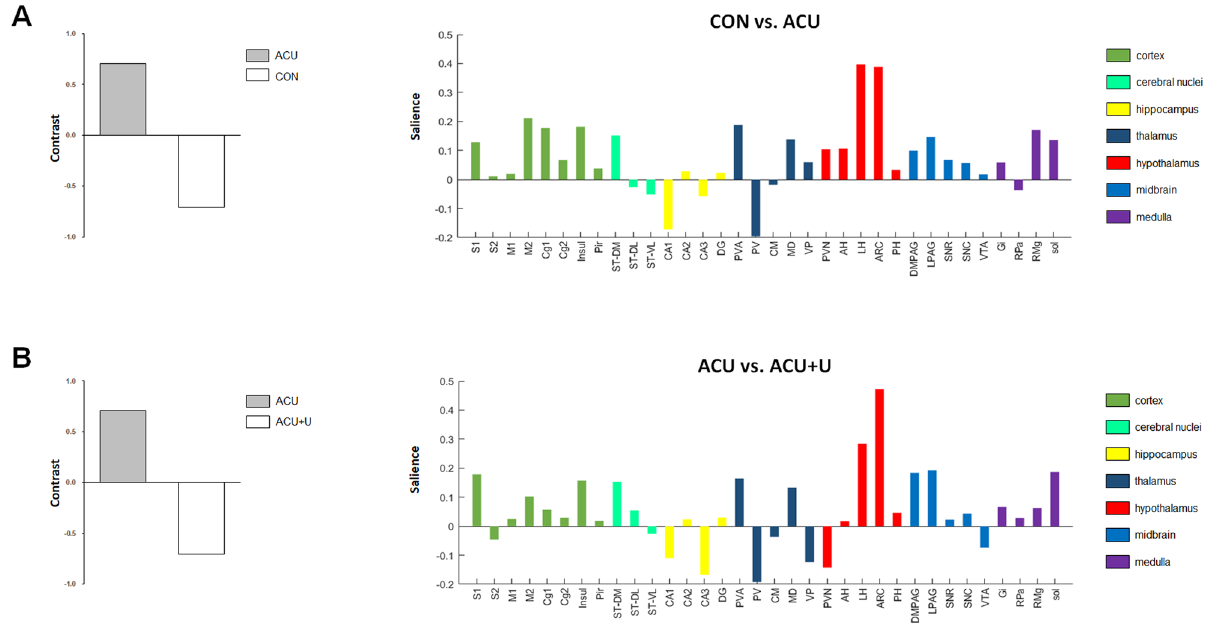
Figure 4. Contrast task PLS analysis of brain c-Fos expression in CON vs. ACU and ACU vs. ACU + U. ( A , B ) Two pairs of ACU vs. CON and ACU vs. ACU + U were compared in the Contrast task PLS analysis of c-Fos expression. The contrast (left) reflects the experimental condition in CON vs. ACU ( A ) and ACU vs. ACU + U ( B ). Salience scores (right) identified that the brain regions which differed in c-Fos expression between the experimental conditions were intensely similar between the ACU vs. CON and ACU vs. ACU + U. In both comparisons, c-Fos expression in multiple brain regions contributed to the contrast, and the hypothalamus contributed the most strongly to this contrast. CON control, ACU acupuncture treatment, ACU + U U0126 administration followed by acupuncture treatment. Abbreviations for each brain region are shown in Table